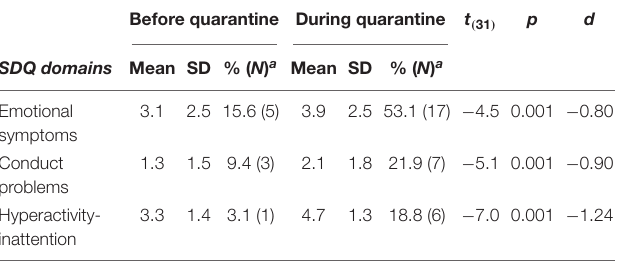
TABLE 4 | Parents’ perceived impact of Spain’s National Quarantine on emotional and behavioral difficulties of children with dyslexia. Before quarantine During quarantine t ( 31 )